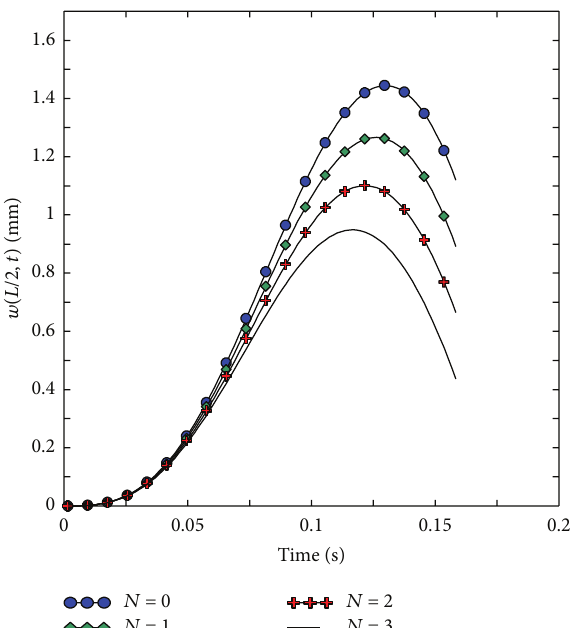
Figure 11: The dynamic response ( 𝑤(𝐿/2, 𝑡) ) for the beam with 𝜁 = 0 , subjected to a moving vehicle and attached to many absorbers.